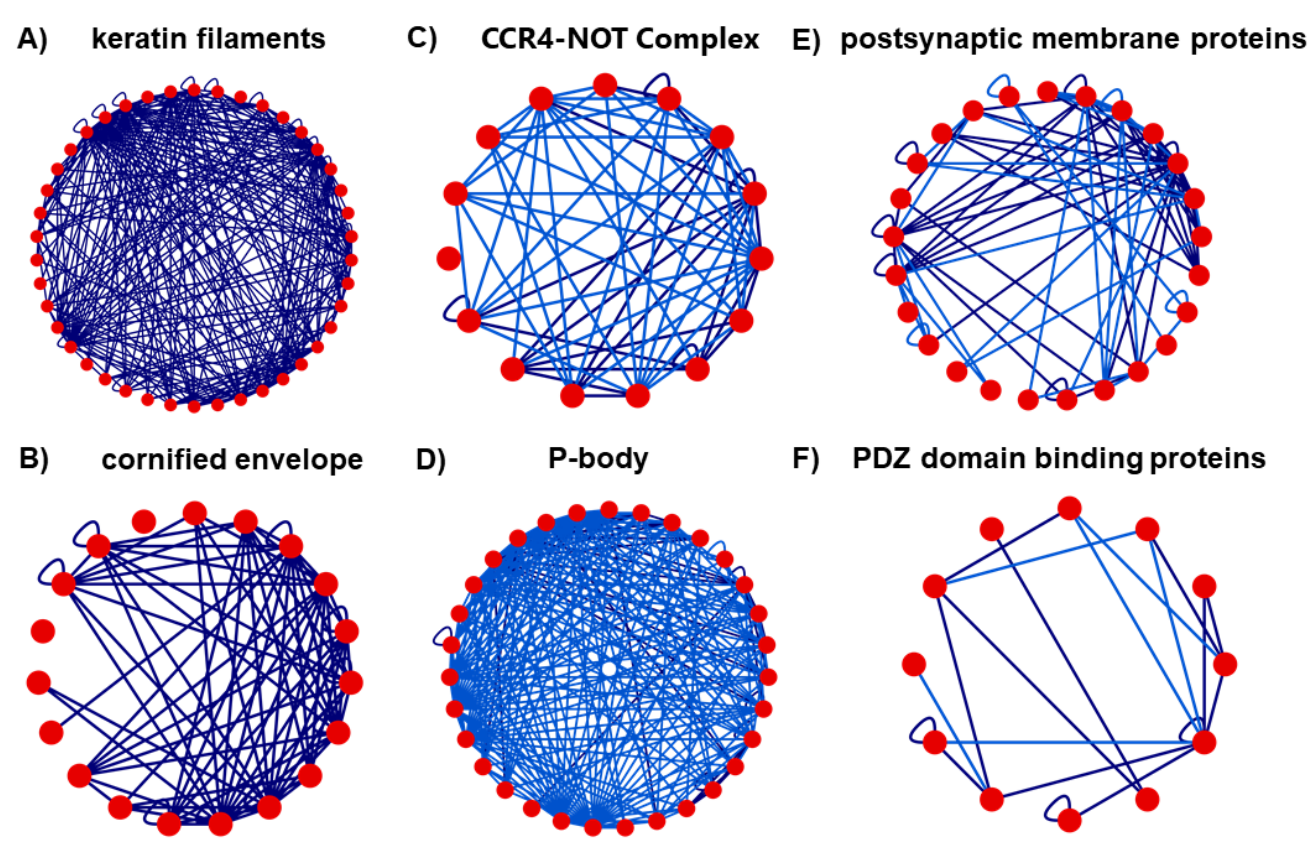
Figure 5. Multiprotein complexes with distinct biological functionality extracted from cluster intersections 2, 3 and 4: Keratin filaments ( A ) and cornified envelope ( B ) protein complexes of intersection 2; CCR-4 NOT ( C ) and P-body ( D ) protein complexes of intersection 3; Postsynaptic membrane ( E ) and PDZ domain binding proteins ( F ) protein complexes of intersection 4. Only the PPIs between the proteins of these complexes in the cluster intersections are shown, as provided and visualized in PICKLE website.